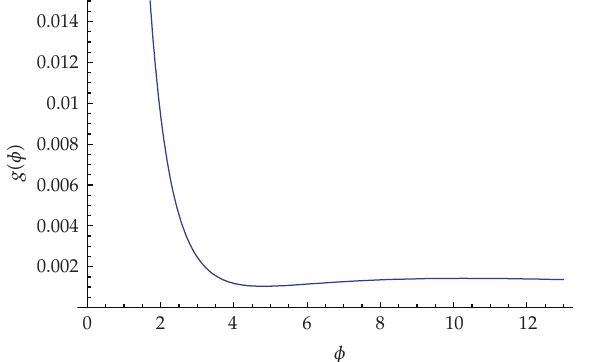
Figure 4: The form of the coupling parameter g (cid:3) φ (cid:6) has been plotted against φ (cid:3) with f (cid:2) 0 . 5 , h (cid:2) 0 . 68 , t 0 (cid:2) 13Gyr , Ω mo (cid:2) 0 . 3 (cid:6) . It remains almost flat at the later epoch of cosmic evolution, ensuring late time